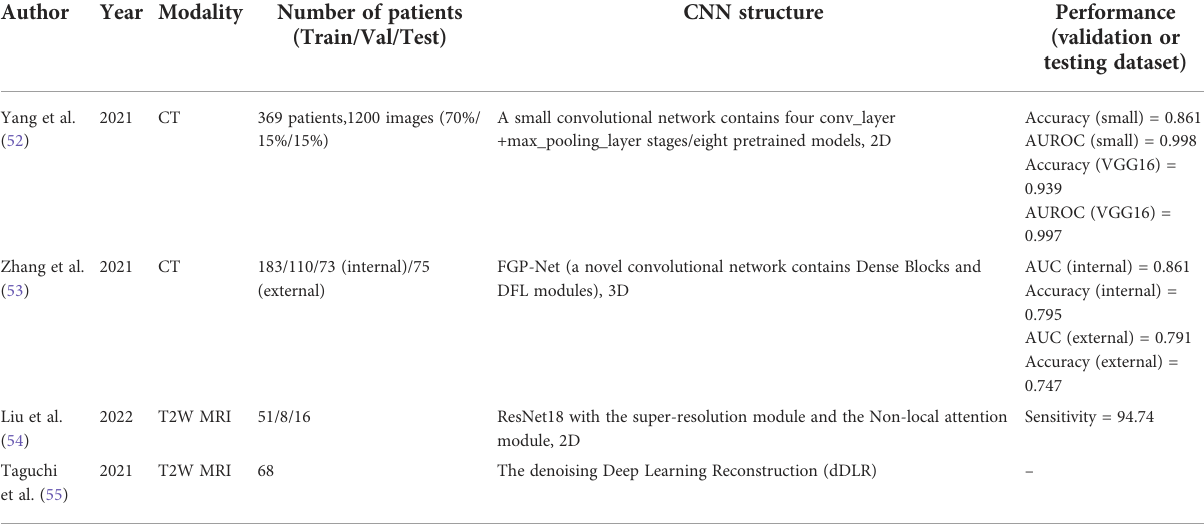
TABLE 2 Studies using deep learning approach for bladder cancer diagnosis and